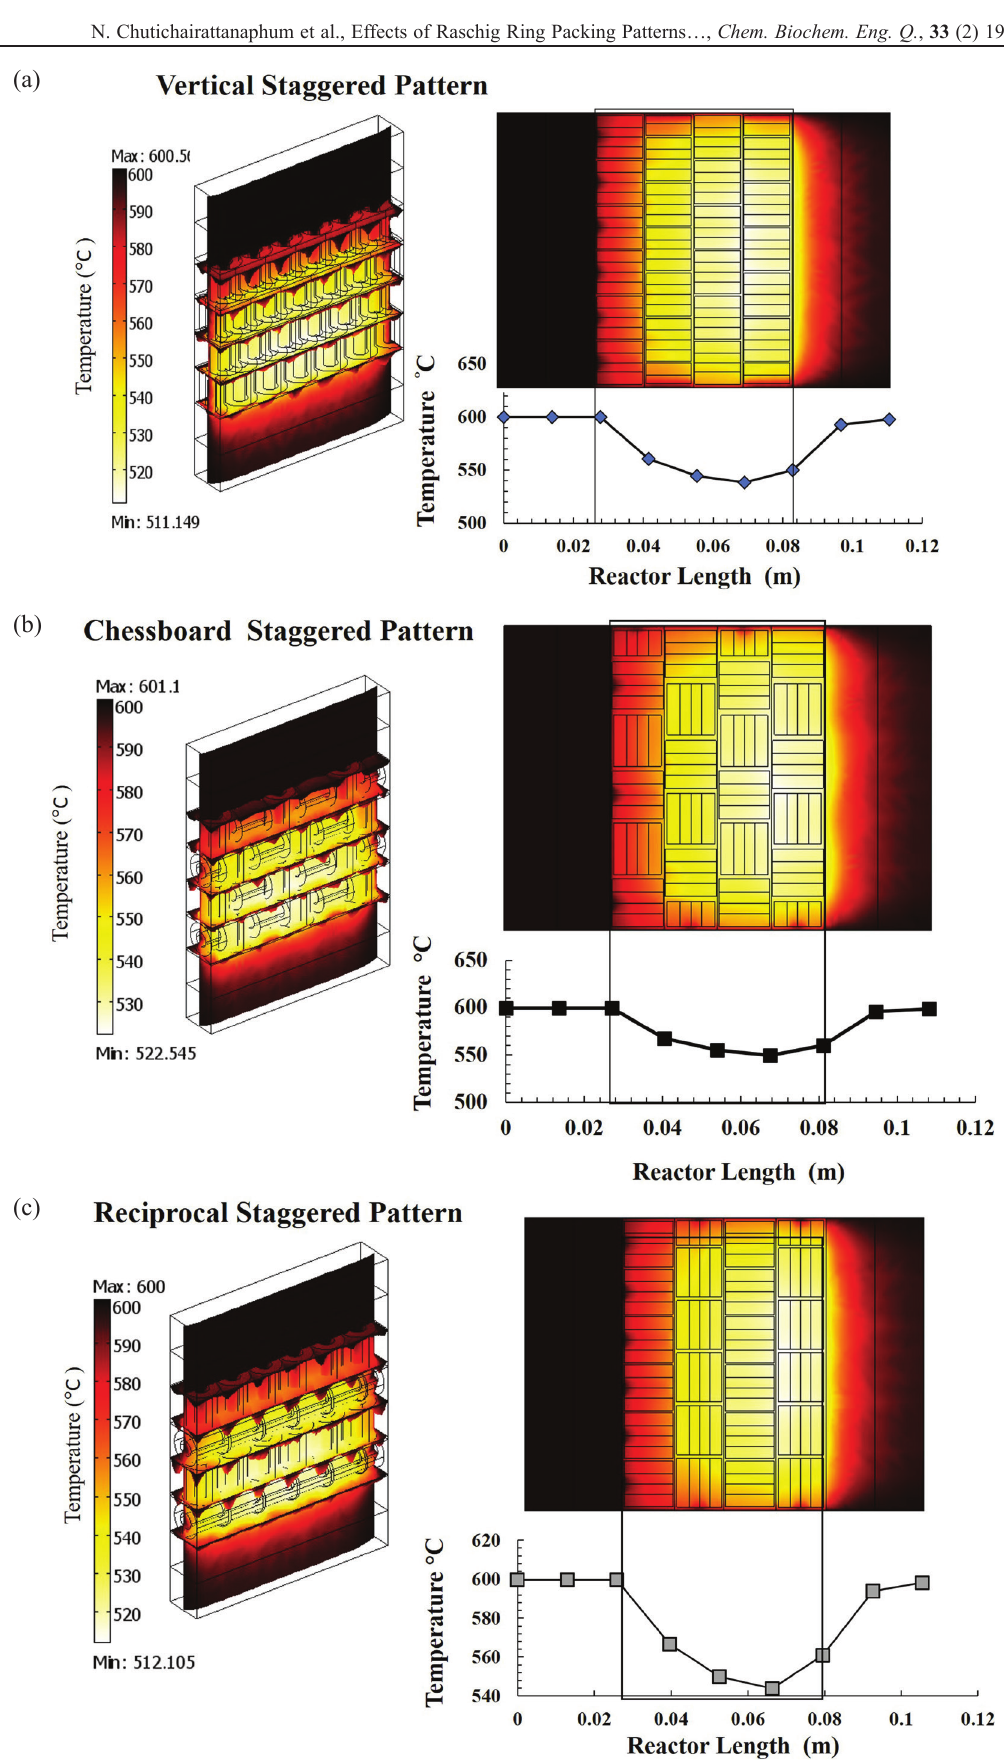
Fig. S9 – Temperature gradient of Raschig ring packing during the